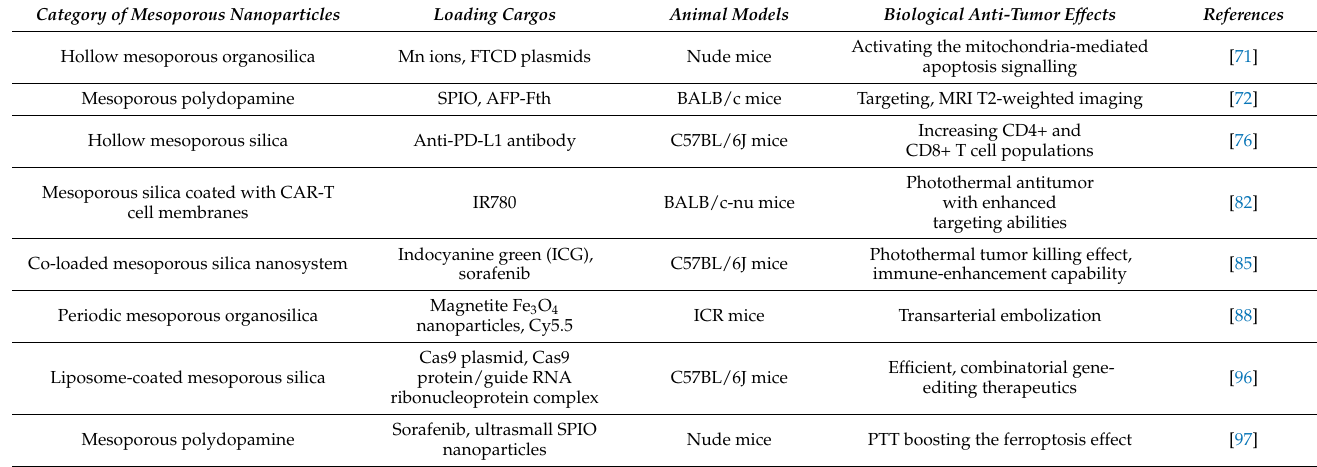
Table 1. Summary of mesoporous nanoparticles application in vivo for